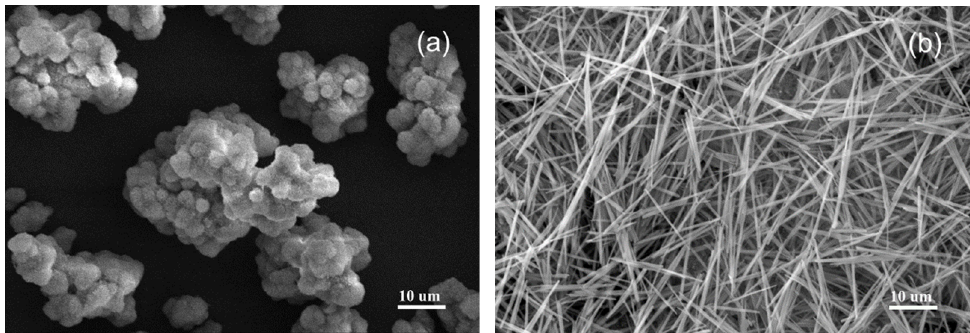
Figure 3. Raman spectra of products with 0 and 0.8 wt% of CS. According to Figure 4, at 0 wt% CS, the product was composed of Mg(OH) 2 particles. The SEM image of the product with a CS content of 0.8 wt% shows the smooth surface Figure 4. SEM images of the products with and without CS; ( a ) 0 wt%; ( b ) 0.8 wt%. and neat morphology of the 517-type BMSWs with high purity. According to previous reports [32,33], the formation of 517-type BMSWs requires an appropriate amount of admixture, such as CS; the mechanism of action of citrate in the reaction is shown in Figure 5. First, the ammonia aqueous solution was dropped into the solution, which was rapidly ionized to generate NH 4+ and OH - . Subsequently, the pH value of the solution increased, and the OH - reacted with the Mg 2+ and H 2 O molecules to form Mg-O 6 octahedrons with a sandwich structure and a specific interlayer spacing. With